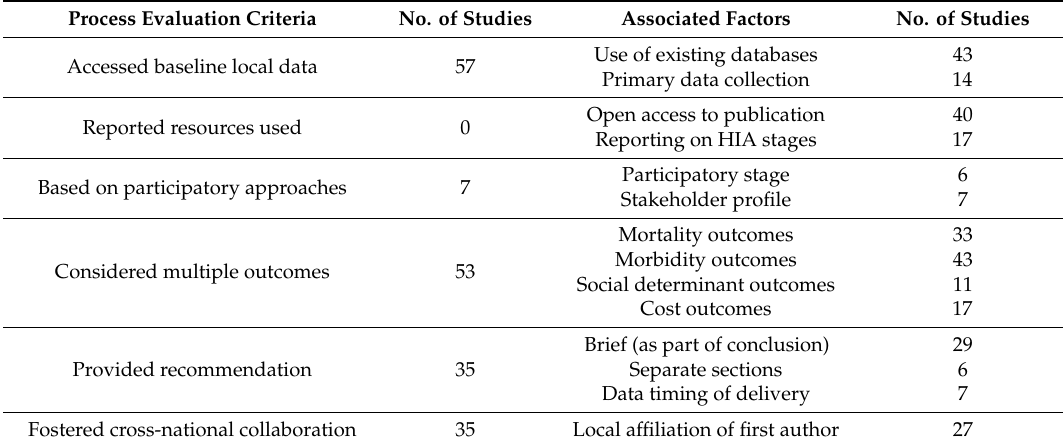
Table 5. Process evaluation